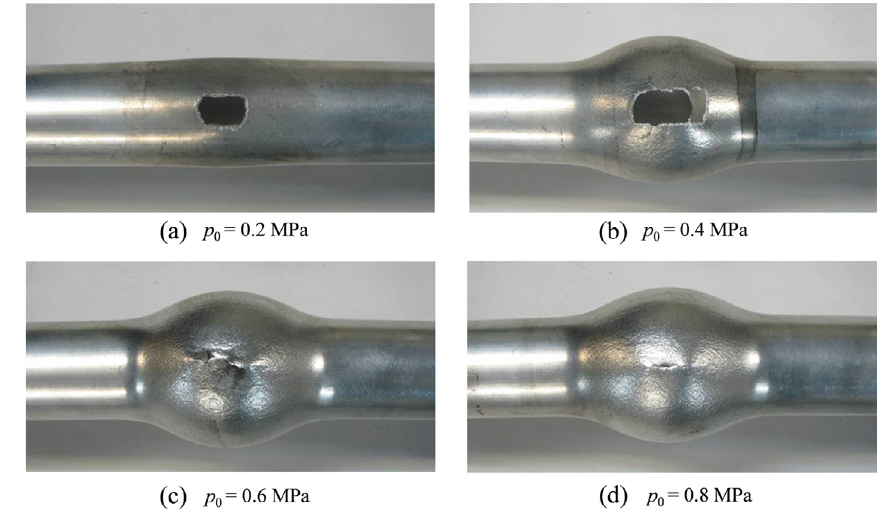
Figure 6. Burst tubes for different initial internal pressures and J = 38 A/mm 2 .